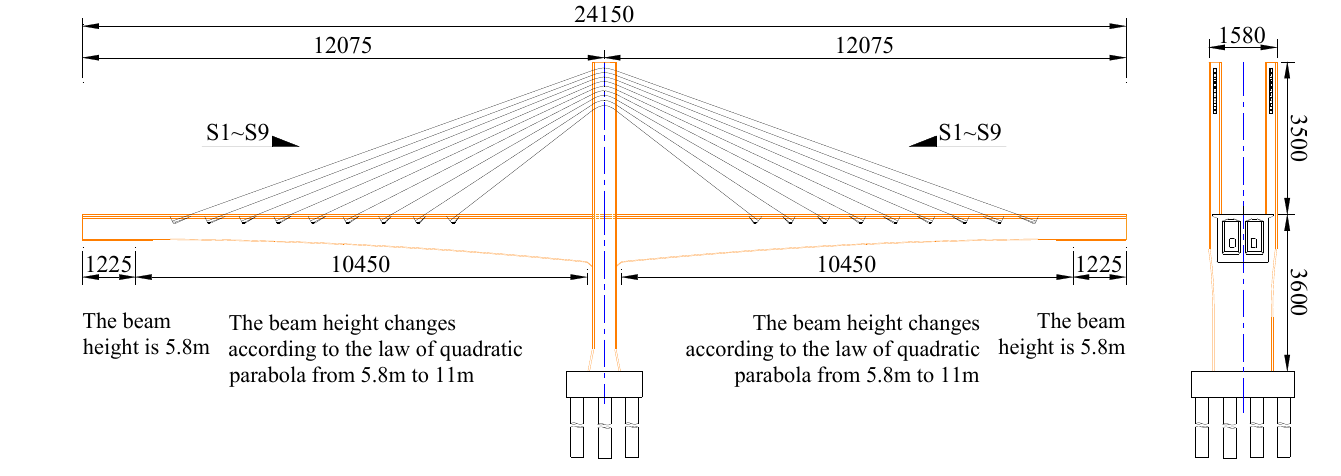
Figure 8. General layout of Nanxi River cable stayed T-frame bridge (unit: cm).